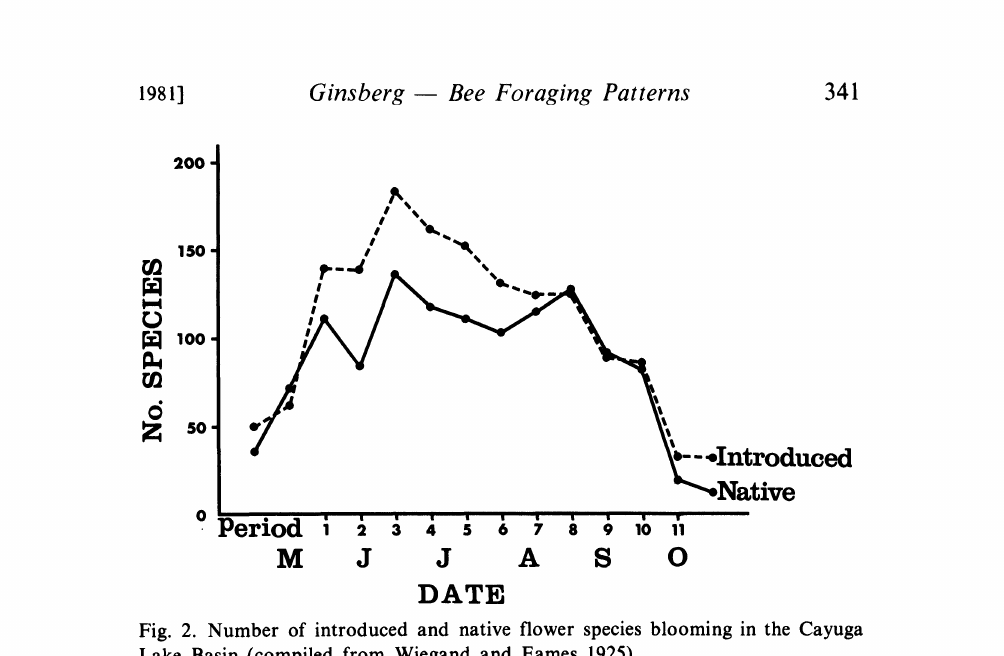
Fig. 2. Number of introduced and native flower species blooming in the Cayuga Lake Basin (compiled from Wiegand and Eames 1925).